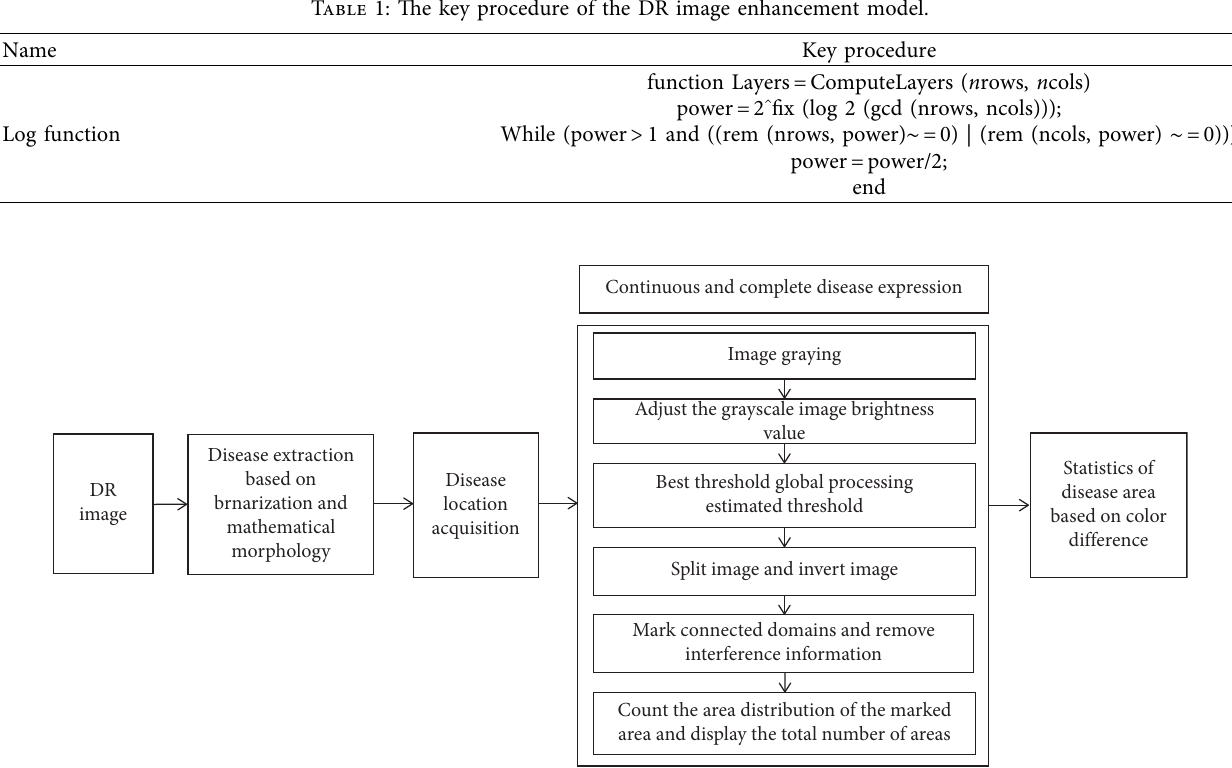
Figure 4: Flowchart of disease edge screening and disease ratio